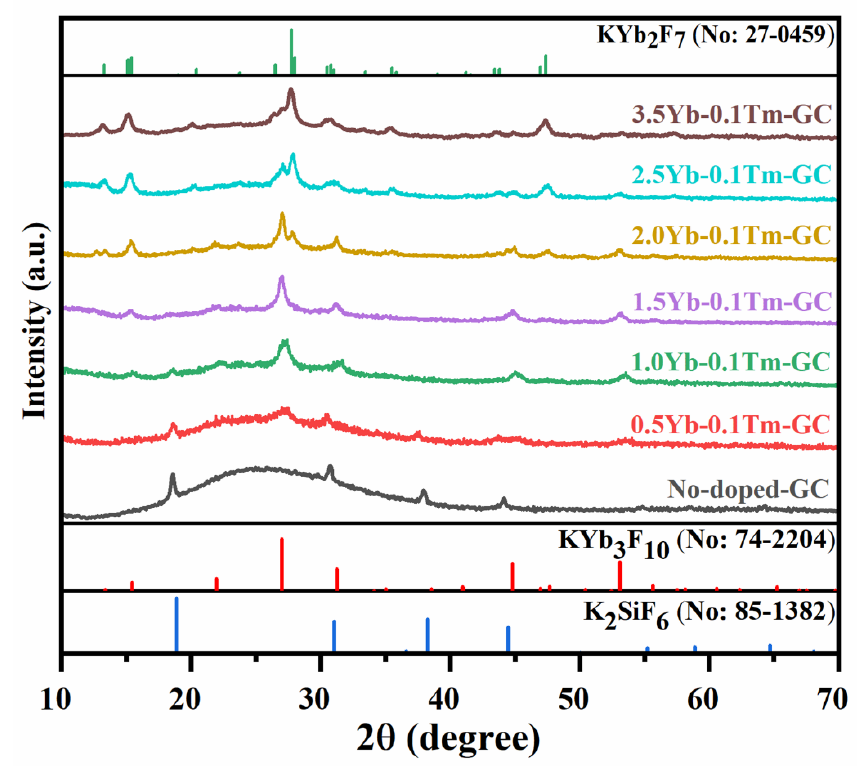
Figure 5. XRD patterns of x Yb 3+ ‐ 0.1Tm 3+ co ‐ doped and no ‐ doped GCs heat treated at 540 °C for 10 h. ( x = 0~3.5%). ( x =